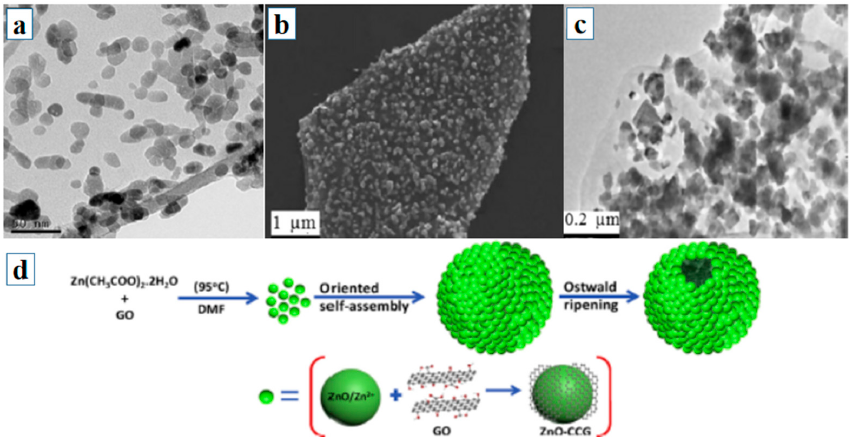
Figure 6. ( a ) Scanning electron microscope (SEM) image of graphene–ZnO quasi-shell–core structure; ( b , c ) SEM images of embedded ZnO nanoparticle–graphene sheet composites; ( d ) growth process of the ZnO–graphene hollow microsphere structure.